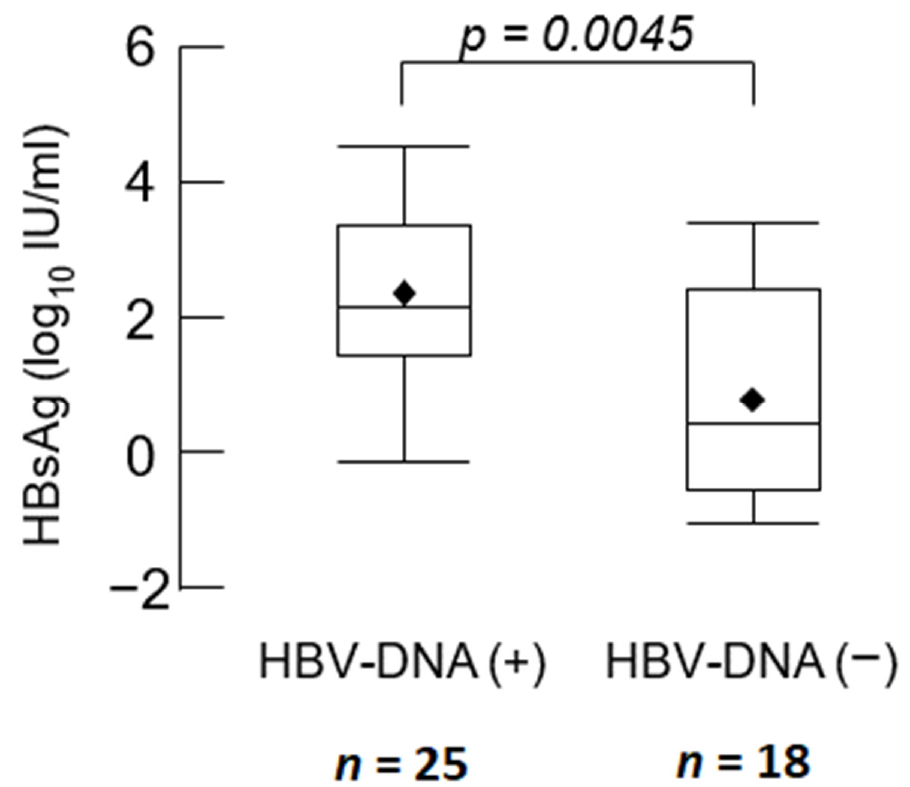
Figure 2. HBsAg levels in HBV-DNA positive and negative patients. Abbreviations: HBsAg, hepatitis B surface antigen; HBV-DNA, hepatitis B virus DNA.